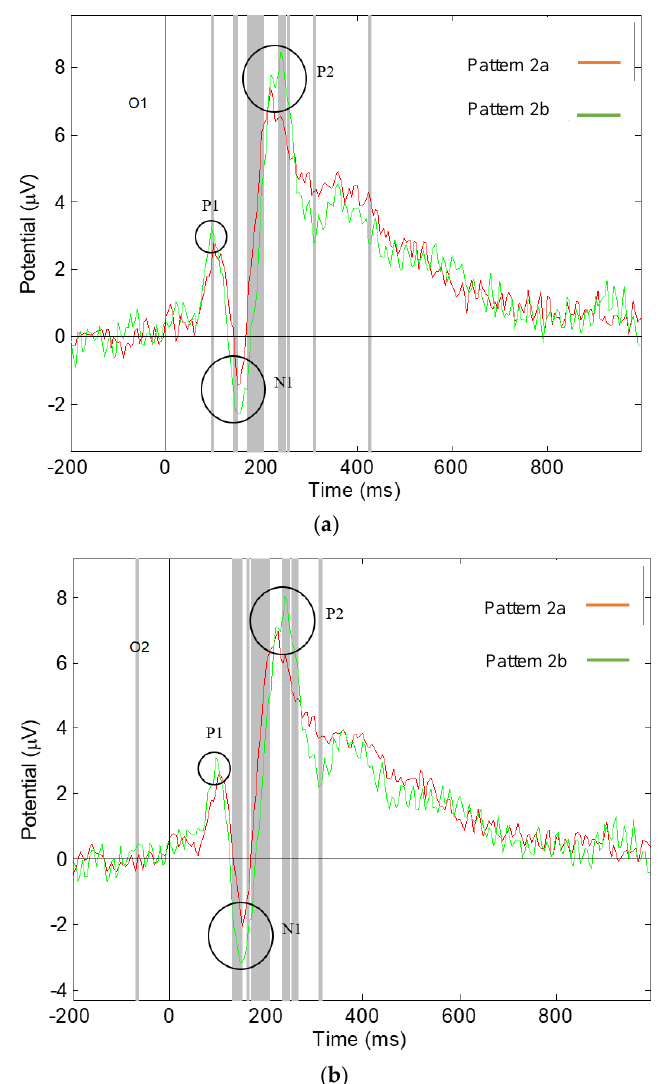
Figure 10. Grand average ERP responding to Pattern 2a,b, the grey lines show the significant di ff erence